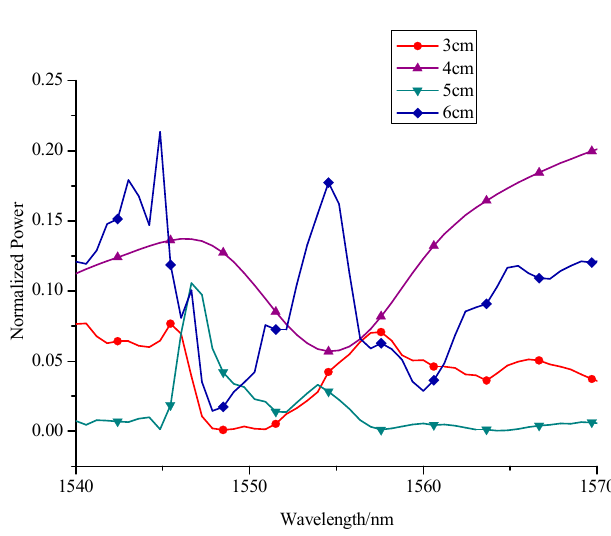
Figure 3. Simulation spectra of SNS interferometer with different lengths of NCF.